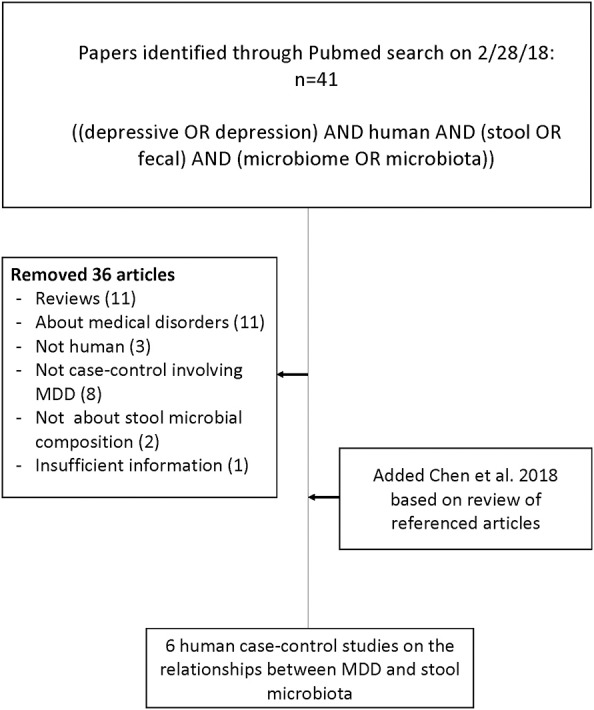
Flow chart of literature search for articles concerning case-control studies of the gut microbiome in major depressive disorder compared with healthy volunteers.